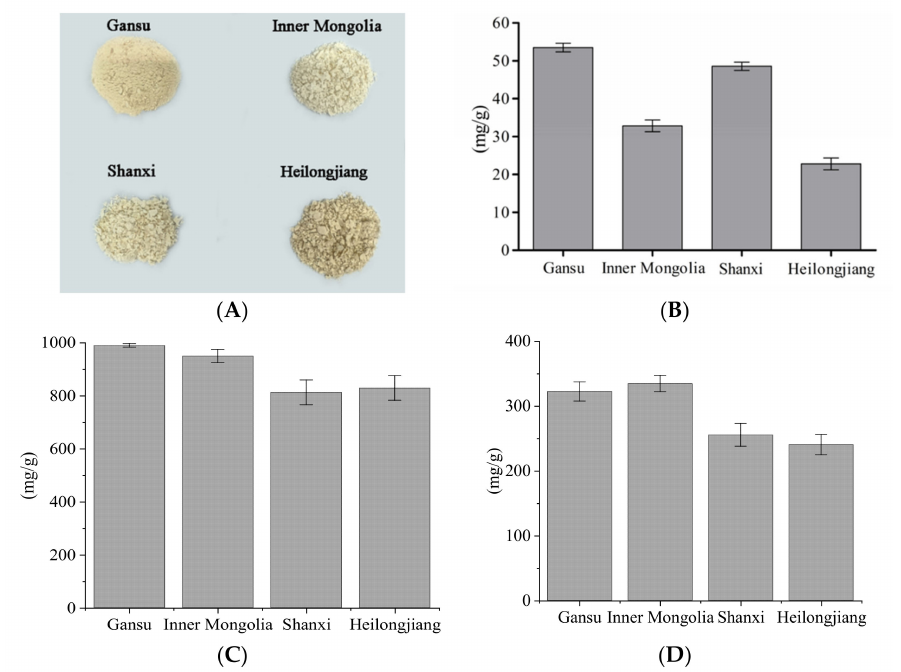
Table 1. Three readings of “L” (lightness), “a” (redness), and “b” (yellowness) indicate the lightness coefficient, red color coefficient, and yellow color coefficient, respectively. Differences values of L*, a*, and b* were used to evaluate the change in different color parameters. The results indicated that ‘Heilongjiang’ polysaccharide extract had a more yellow-green color (b*) than the other origins sample. The yield of APS was determined. It was in decreasing order, ‘Gansu’ > ‘Shanxi’ > ‘Inner Mongolia’ > ‘Heilongjiang’. The ‘Gansu’ polysaccharide extract had the highest content of polysaccharides (Figure 1C). In Figure 2, the neutral monosaccharide compositions were determined by gas chromatog- raphy. Compared with the monosaccharide standard, APS from different origins had identical monosaccharide compositions, including arabinose, glucose, and galactose. By combining the NMR data, galacturonic acid was found as the only uronic acid in APS. The content of galacturonic acid was detected by the colorimetric m-hydroxyl diphenyl protocol and the results showed that ‘Gansu’ and ‘Inner Mongolia’ had higher uronic acid levels. Furthermore, glucose was the major monosaccharide due to the high molar ratio in all samples. It is worth mentioning that the water solubility of APS was in decreasing order, ‘Shanxi’ > ‘Gansu’ > ‘Heilongjiang’ > ‘Inner Mongolia’. The endotoxin (liposaccharide) was determined in this work. All the samples had endotoxin levels below 0.1 EU/mL. It indicated that these polysaccharides were in the safe range.